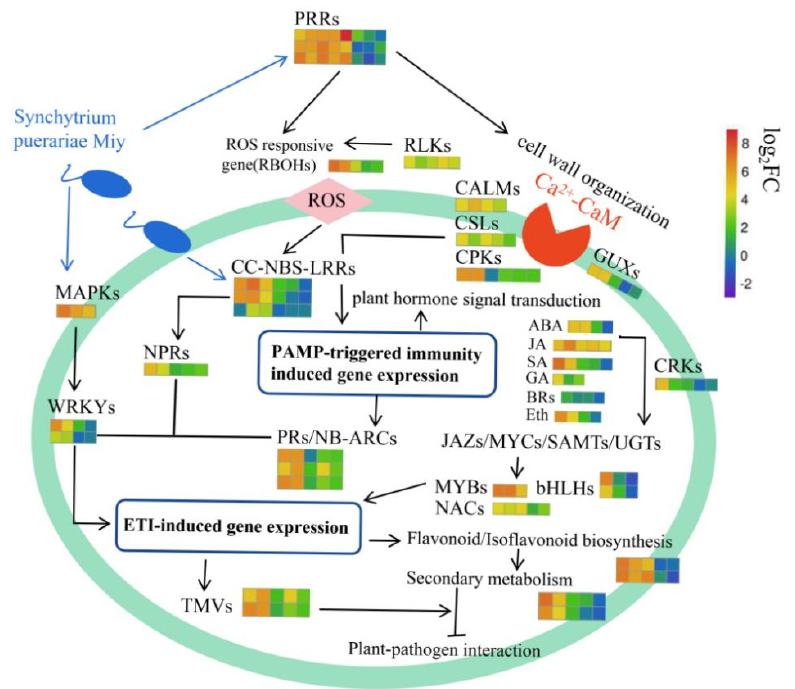
Figure 12. Hypothetical model of resistance to SpM ( Synchytrium puerariae Miy) mechanism related DEGs in Pueraria Lobata based on transcriptomics analyses.